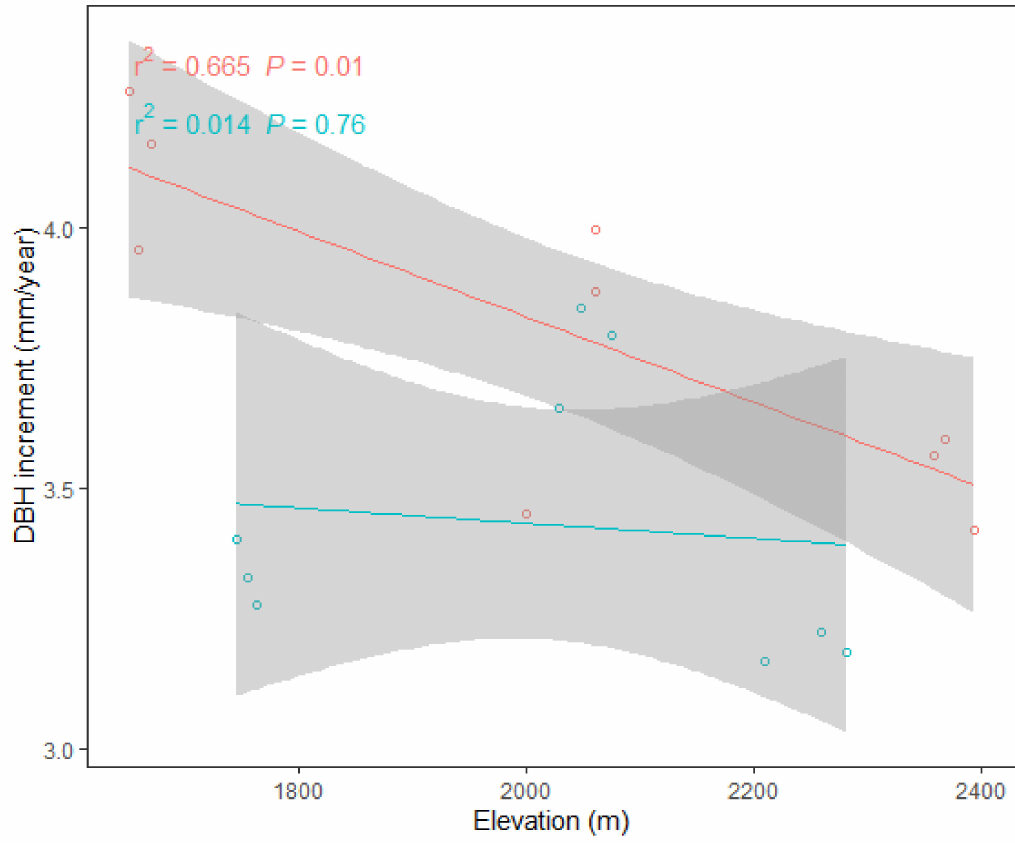
Figure 5. Changes in annual DBH increment with elevation for two origins of Larix principis-rupprechtii forests (red and blue are planted and natural, respectively). Lines and shade represent fitted regressions and corresponding 95% confidence